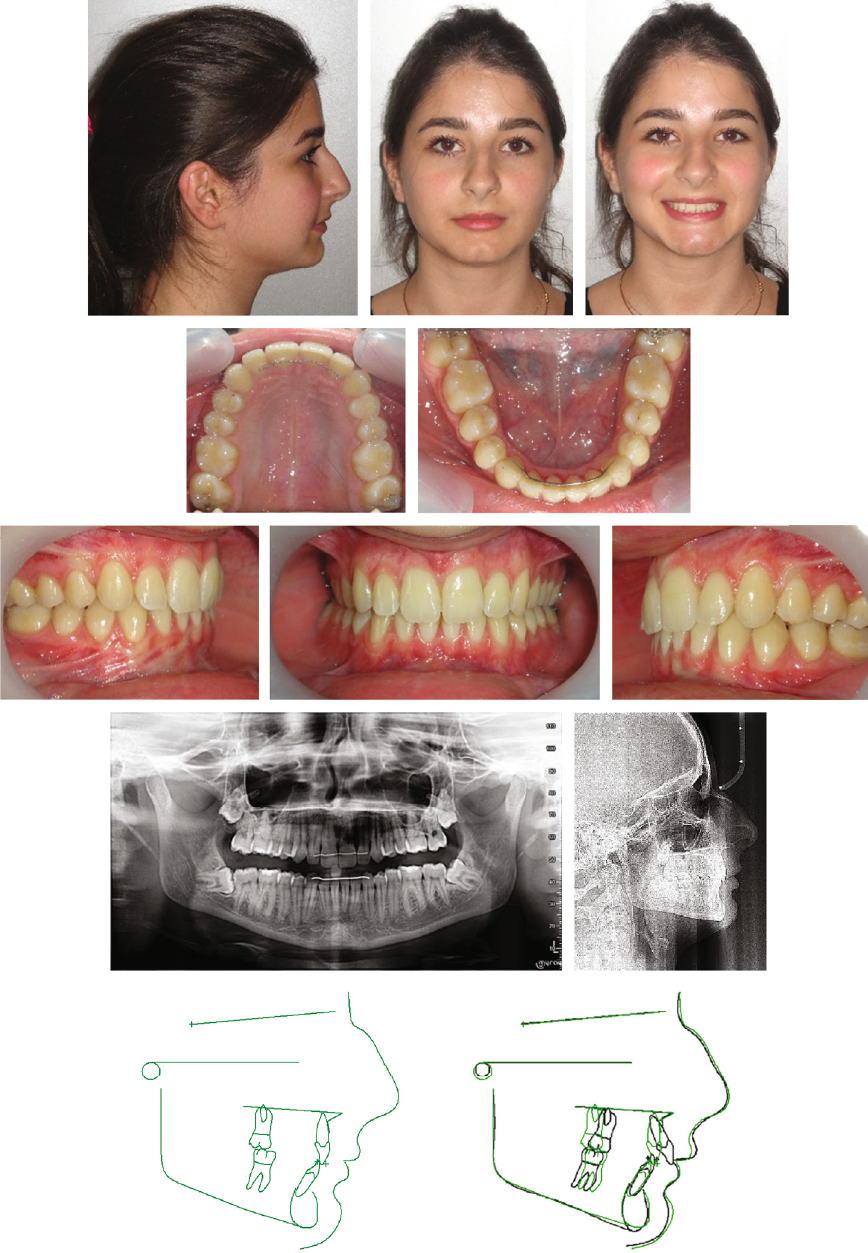
Figure 14: Case 2. Patient three years after